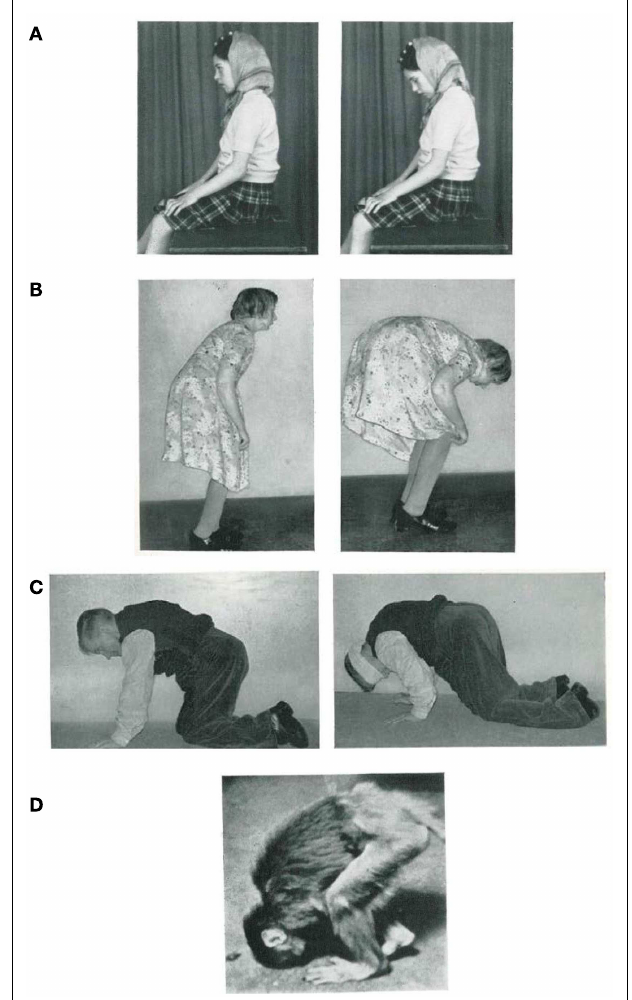
FIGURE 1 | (A) Postural fixation of the head is impaired at all times ( left ), but as soon as the patient closes her eyes her head falls forward until her chin rests on her chest ( right ). (B) Patient standing as erect as she can ( left ), and 2 or 3min later ( right ). (C) Patient’s usual position when on all fours ( left ), and 1min after blindfolding ( right ). (D) “Flexed posture” in a monkey with severe bilateral degeneration of the Globus pallidus [adapted from Martin (1967), with